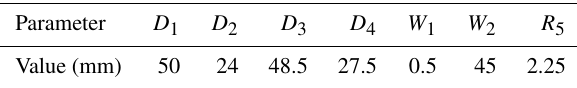
Table 3. Specific parameters of the optimized elastic